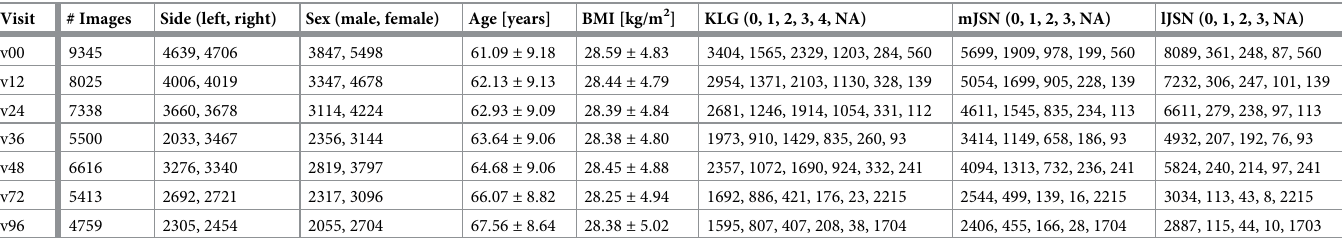
Table 1. Demographics of data used in this study summarized for all considered time points of the OAI database. Visit Side (left, right)